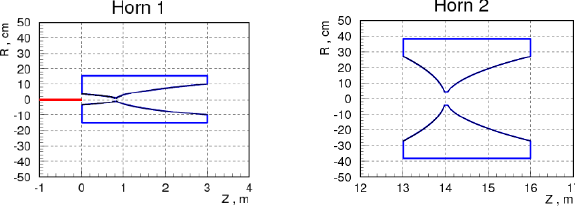
Figure 4. Two horns scheme of the focusing system. Horn currents are equal to 220